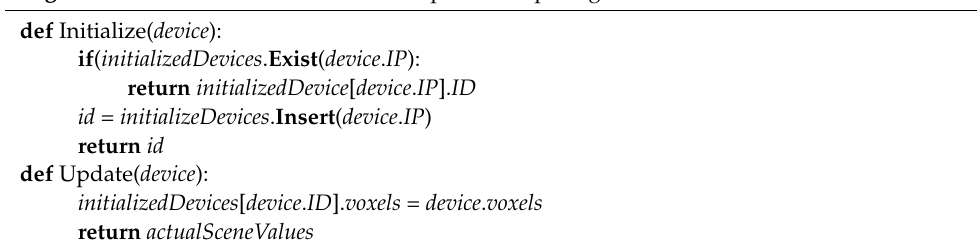
Algorithm 8 Methods for Initialize and Update computing